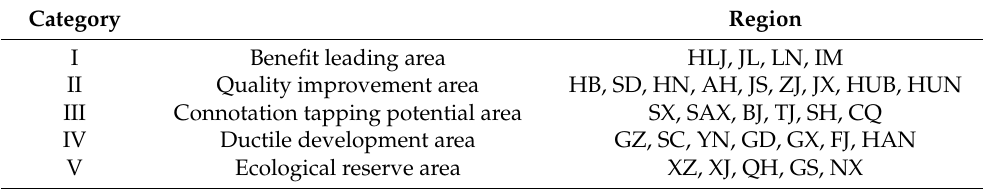
Table 4. Regulation type